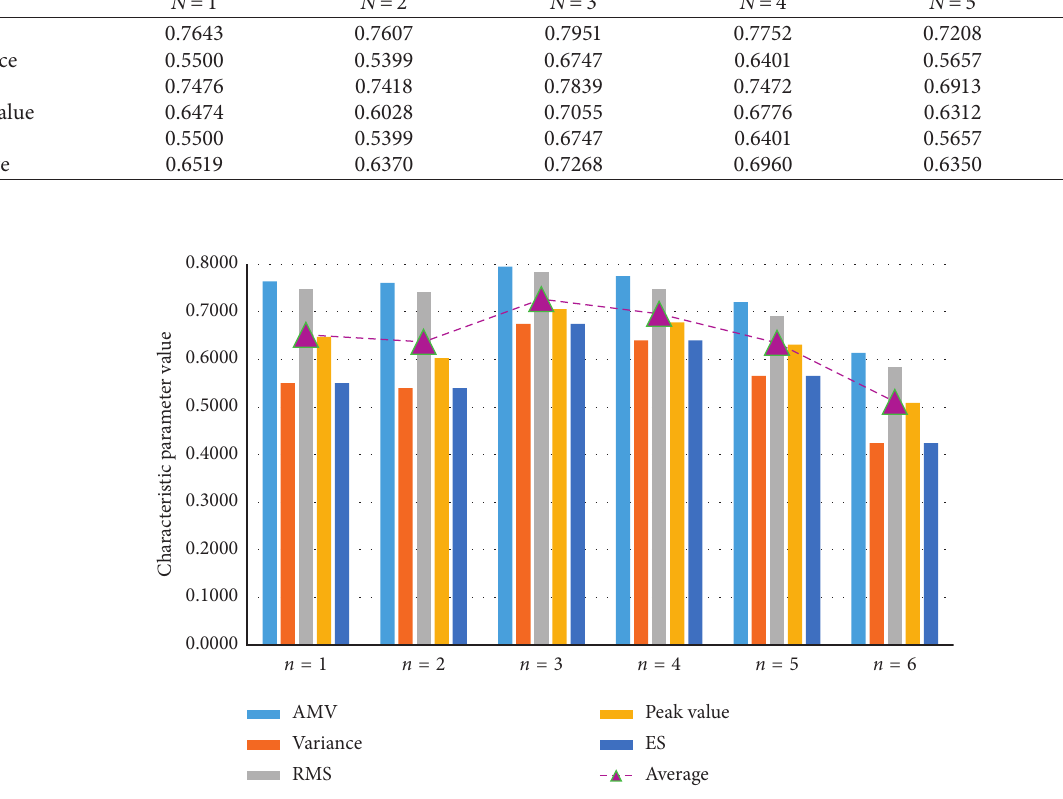
Figure 11: Diagram of fusion indicator values for decomposing characteristic parameters of different decomposition